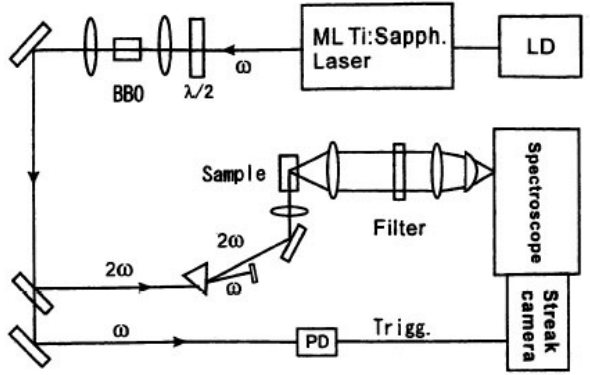
Figure 11. The schematic diagram of ultra fast time resolved FRET measurement system composed of a mode locked Ti:sapphier laser (ML Ti:Sapph.Laser), which was excited with a power controlled diode laser (LD) and a streak camera with a monochromator. Excitation laser pulses are extracted with the electro-optic modulator. A frequency doubled laser beam was generated using a nonlinear BBO (beta barium borate: β BaB Fluorescence from luminous protein excited with a frequency doubled laser beam is detected and stored two dimensionally (temporal, spectral) using a photon counting Streak camera